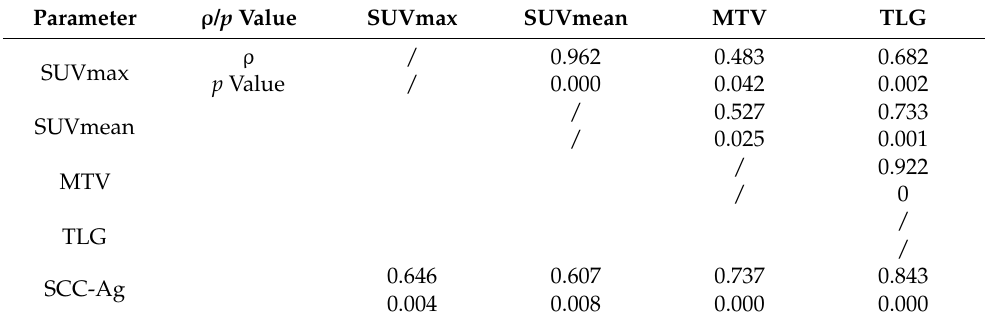
Table 2. Spearman’s rank correlation coefficients between different tumor metabolic parameters and